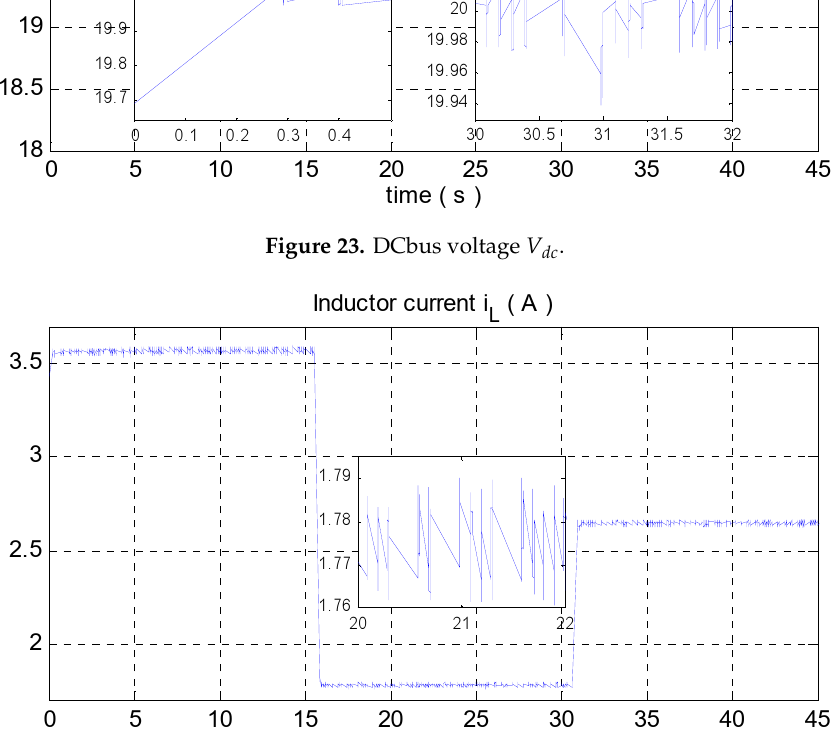
Figure 24. Inductance current i L